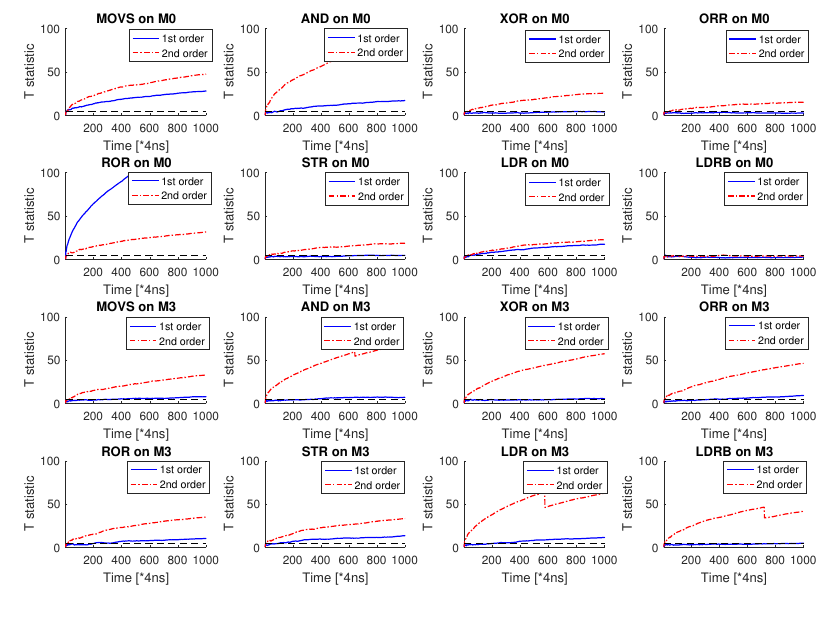
Figure 12: Instruction-wise leakage analysis: other instructions